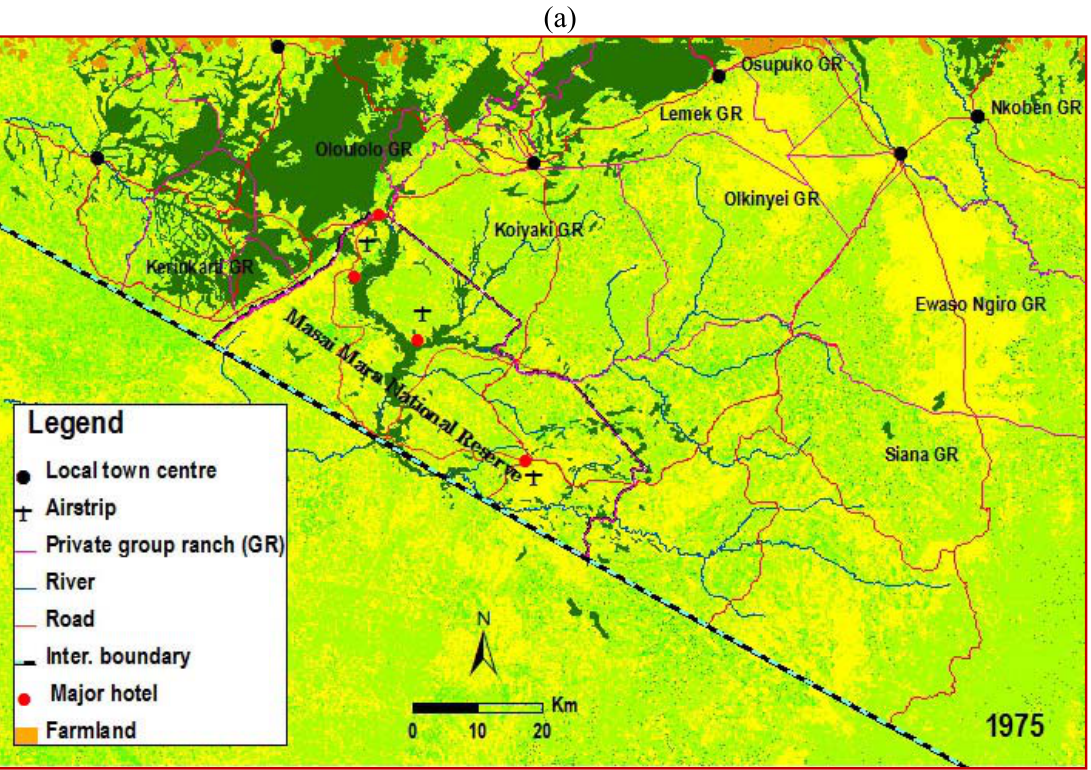
Figure 8. Maps showing the extent of agricultural expansion and mushrooming tourism facilities in Masai Mara Ecosystem. Tourist facilities have increased from five in 1975 to 140 in 2007: (a) 1975 scenario; (b) 2007